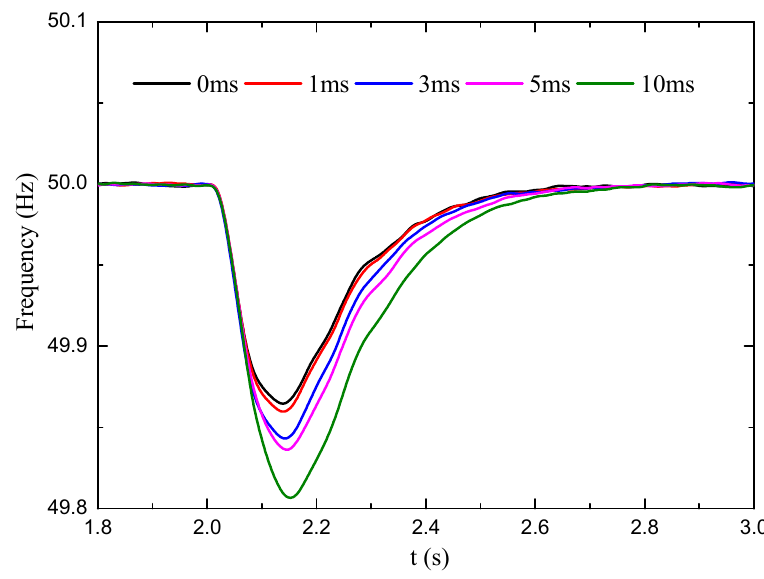
Figure 9. The comparison of frequency regulation with different communication delays.